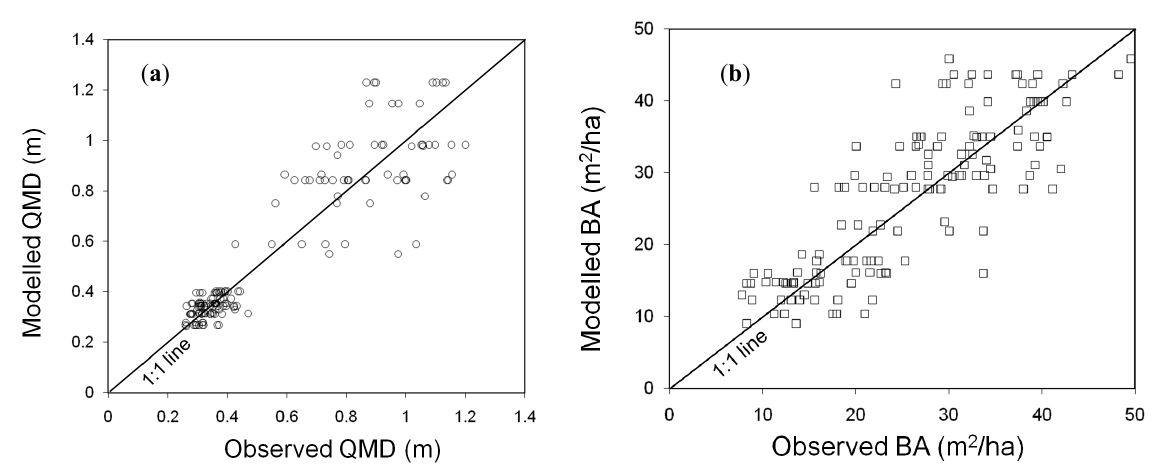
Figure 4. Plot of the observed structural parameters QMD ( a ), BA ( b ), and N ( c ), versus estimated values for the validation subsample (n =